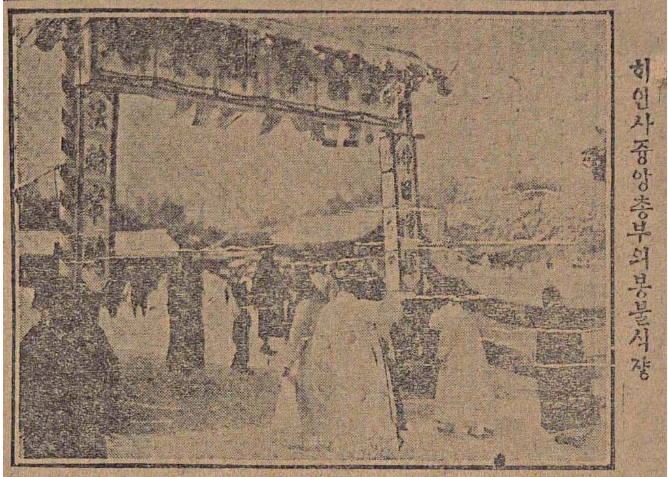
Figure 7. Central Headquarters of Haeinsa on the day of the Buddha Installation Ceremony. After Maeil sinbo , 26 December 1920. Courtesy of the National Library of Korea. 3. Creating a Visual Emblem of Propagation: The Painting and Its